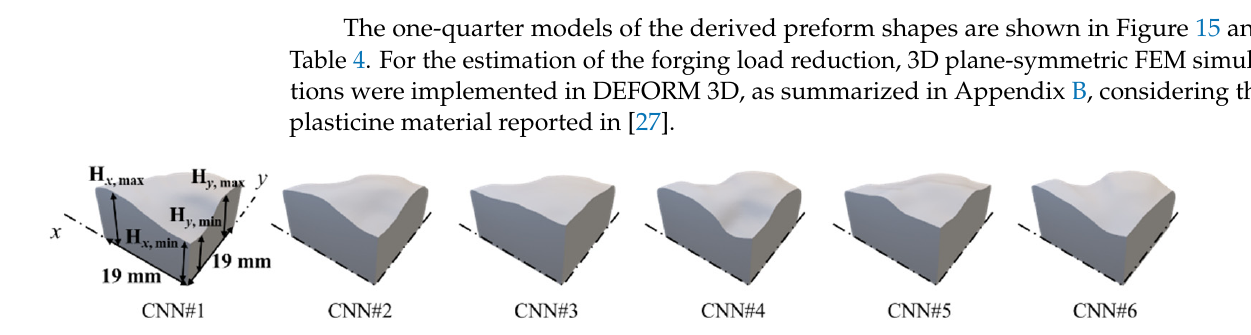
Figure 14. The grinding tool-like forging shape [26].